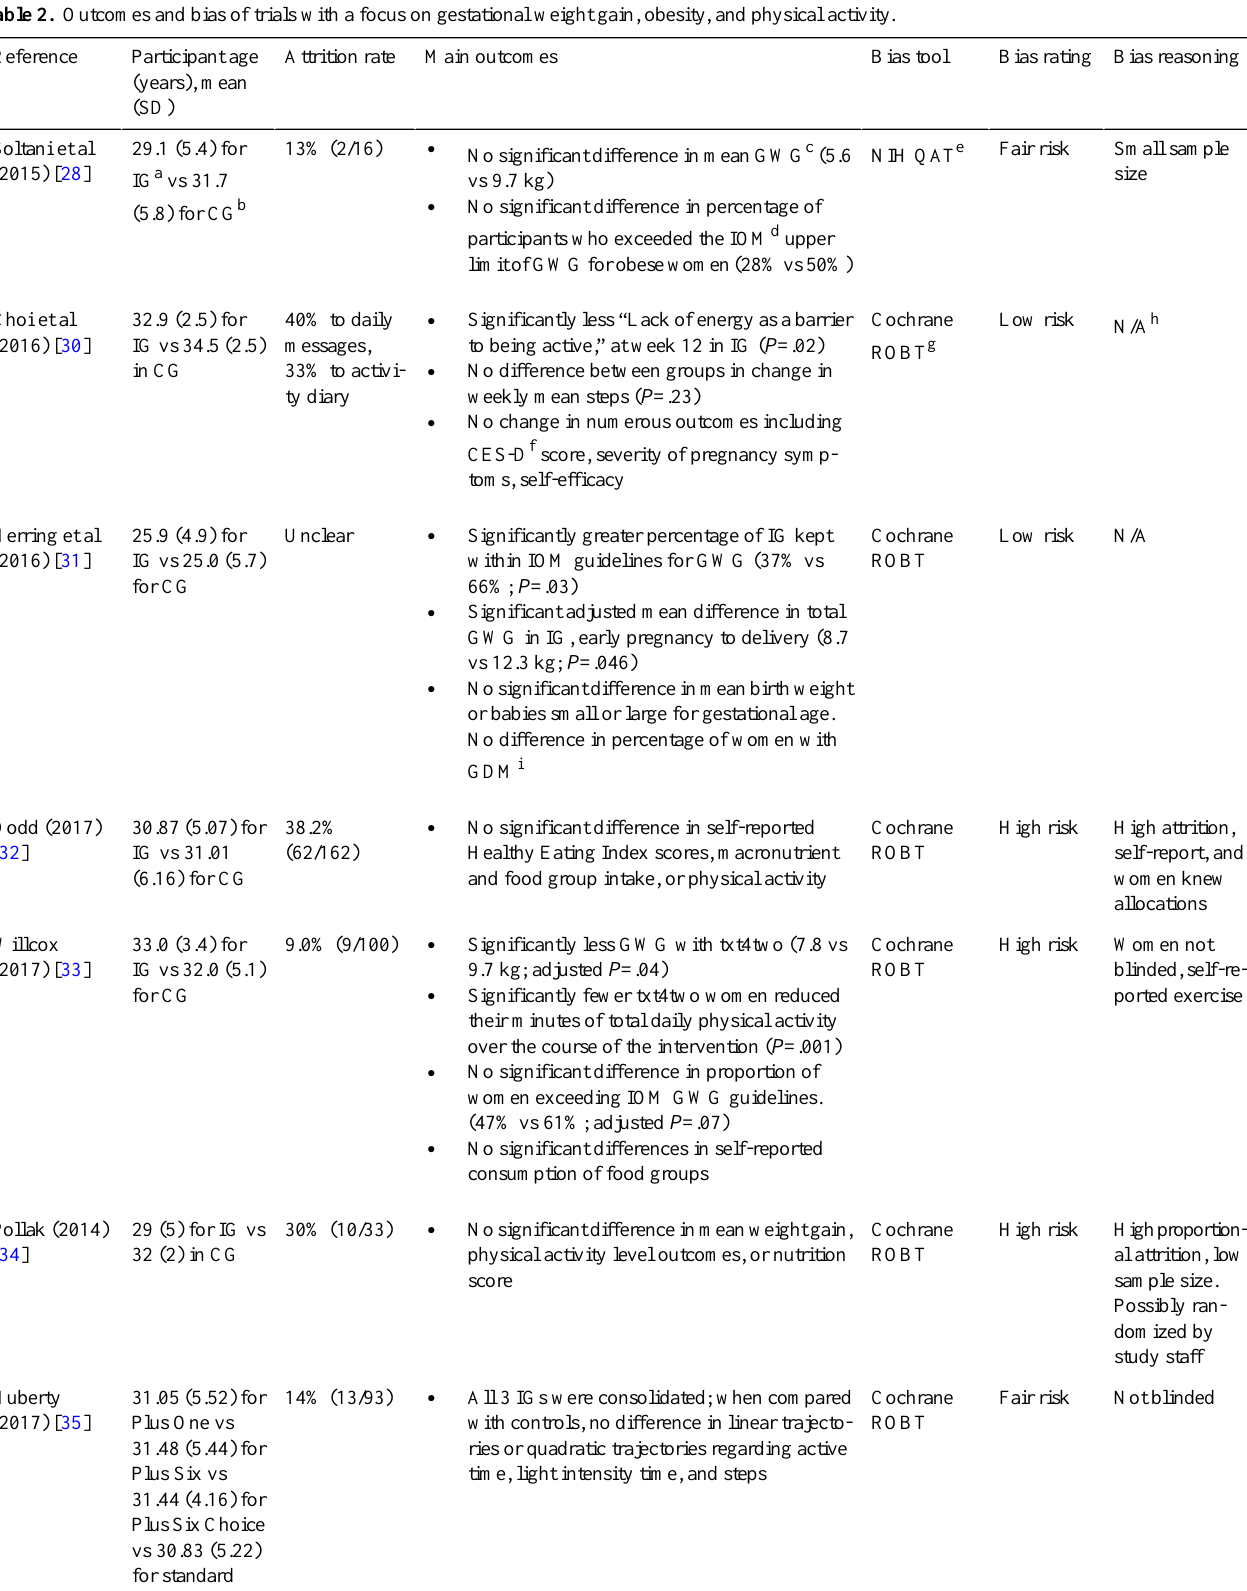
Table 2. Outcomes and bias of trials with a focus on gestational weight gain, obesity, and physical activity.